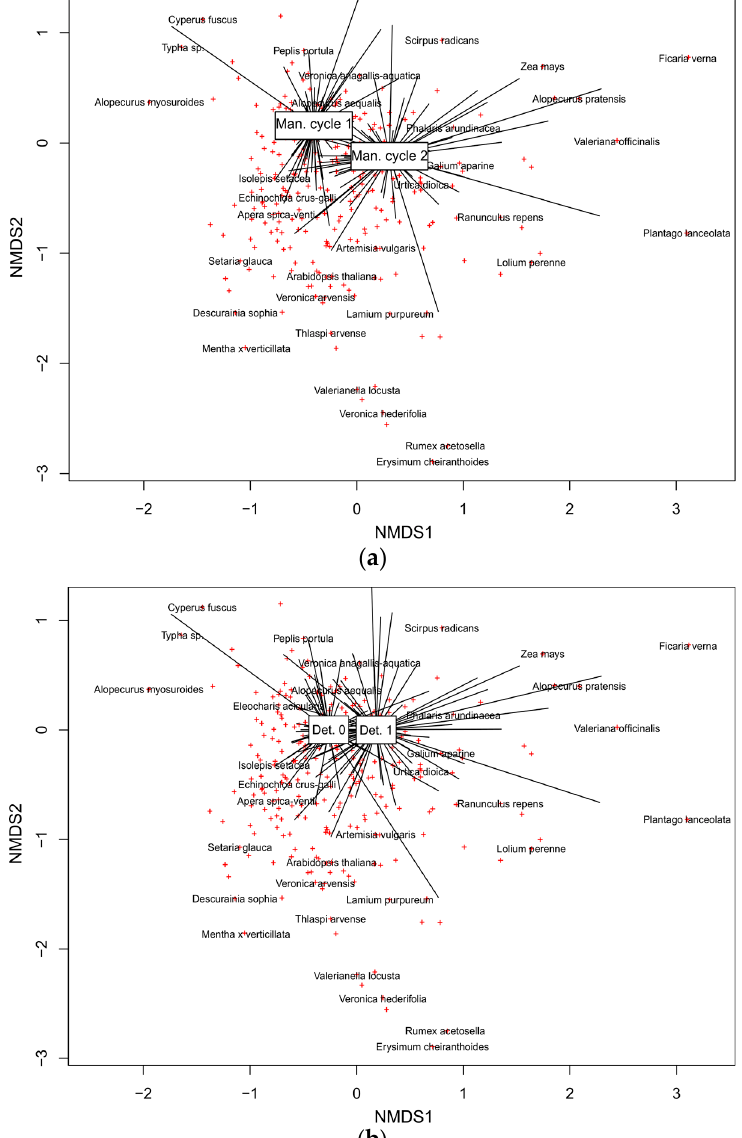
Figure 7. NMDS ordination diagrams of selected environmental factors and their relationship with the species composi- tion of vascular plant and charophyte assemblages of the Dehtá ř fishpond: ( a ) Factor “year of the management cycle”; Man. cycle 1 = 1st year of the management cycle, Man. cycle 2 = 2nd year of the management cycle; ( b ) Factor “organic detritus”; Det. 1 = organic detritus present in more than 20% of the segment area, man. 0 = organic detritus present in less than 20% of the segment area. For a more detailed explanation of all individual variables, see Table